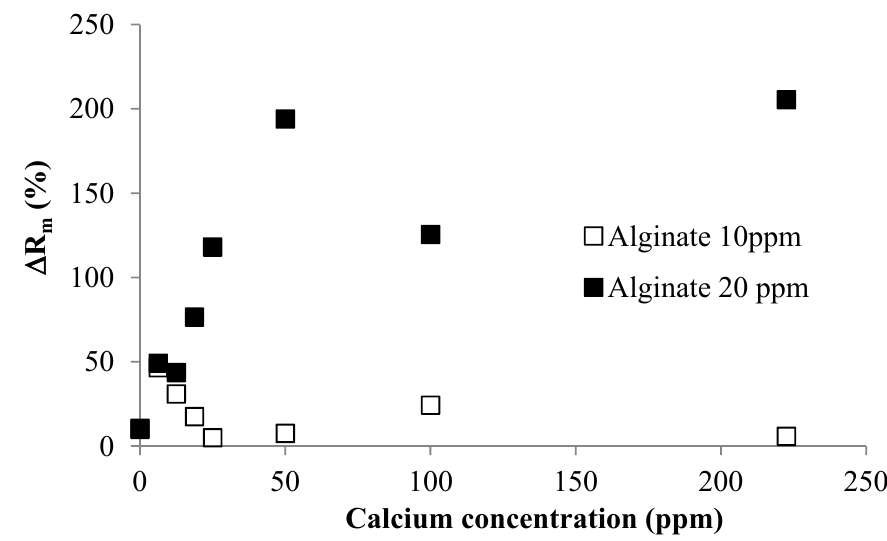
Figure 7. Effect of calcium addition on irreversible resistance (flux 40 LMH; 2 mM NaHCO 3